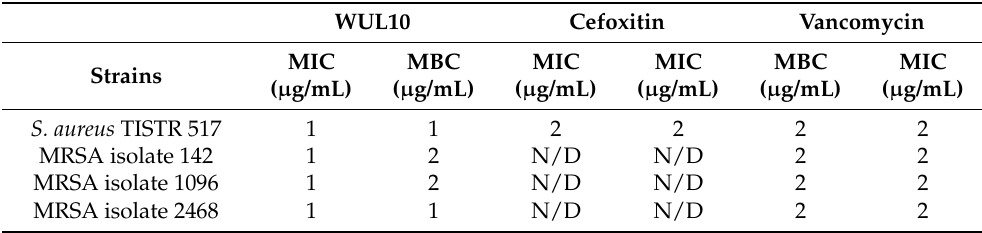
Table 3. Microdilution assay to determine MIC and MBC of pure substance from WUL10 and standard antibiotics (n = 3).